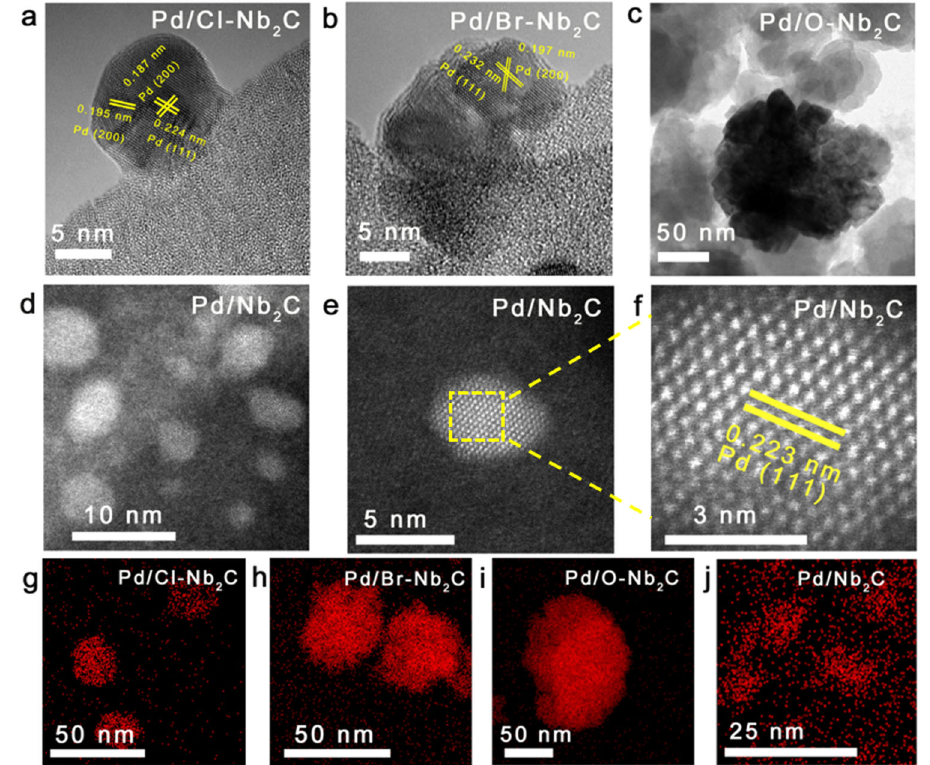
Fig.2|MicrostructureofPd/Nb 2 CMXenes.a – c TEMimagesofPdsupportedonfunctionalgroups-modi fi edNb 2 C, a Pd/Cl-Nb 2 C. b Pd/Br-Nb 2 C. c Pd/O-Nb 2 C. d – f HRTEM and AC-HAADF-STEM images of Pd/Nb 2 C. g – j Elemental mapping of Pd/Cl-Nb 2 C, Pd/Br-Nb 2 C, Pd/O-Nb 2 C and Pd/Nb 2